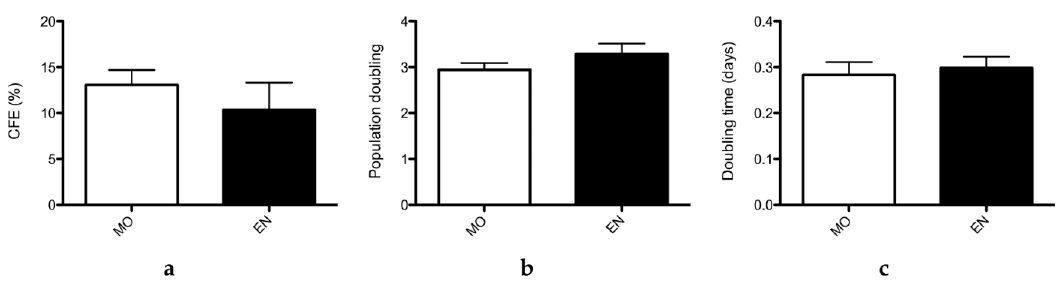
Figure 3. Stem cell properties of encapsulated cells (donors 16,023 at P3 and P4, 16,198 and at P3, n = 4). ( a ) CFE (colony forming efficiency) determined for the three donors in the MO (monolayer) condition and in the EN condition (encapsulated for 7 days then re-seeded as a monolayer after dissolving the microparticles). ( b ) Population doubling for ASCs from the three donors in the monolayer (MO) or encapsulated (EN) conditions. ( c ) Doubling time for ASCs from the three donors in the monolayer (MO) or encapsulated (EN) conditions.